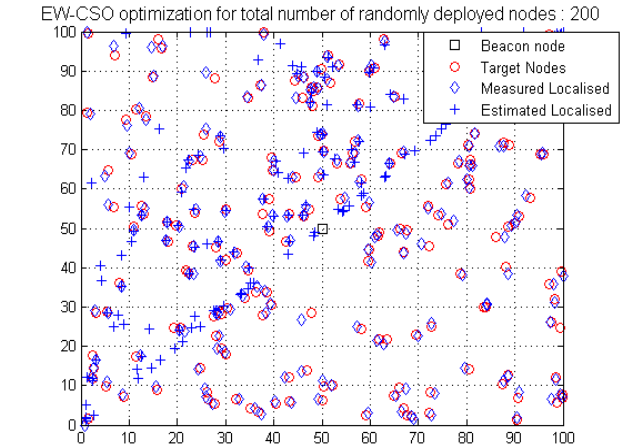
Figure 6. EW-CSO algorithm for randomly deployed mobile sensor nodes located in the target area